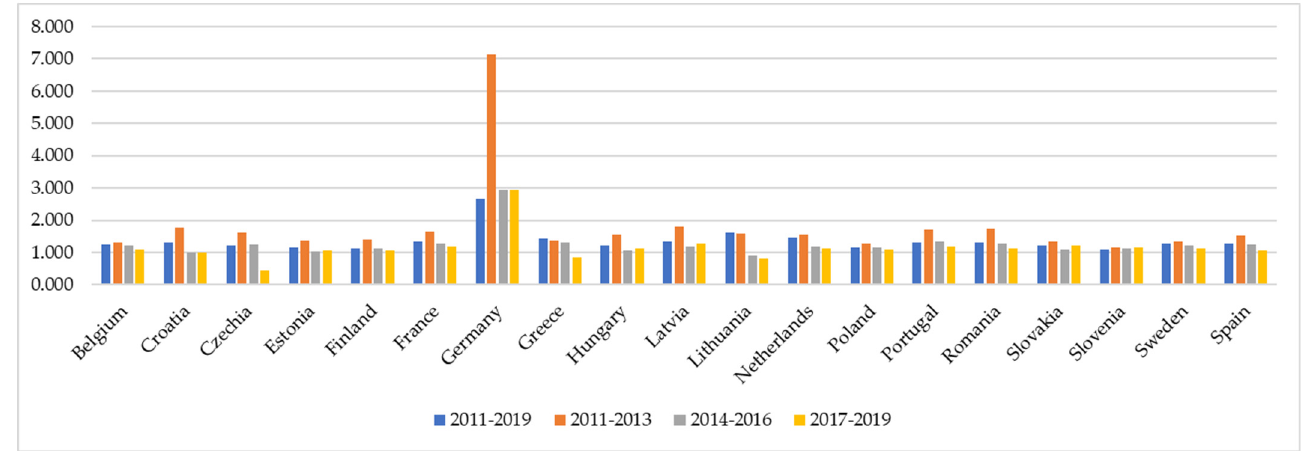
Figure A1. Solvency risk by country, full period, and three sub ‐ periods—high solvency risk category. Note: the graph shows the median values of the TD/SF ratio.